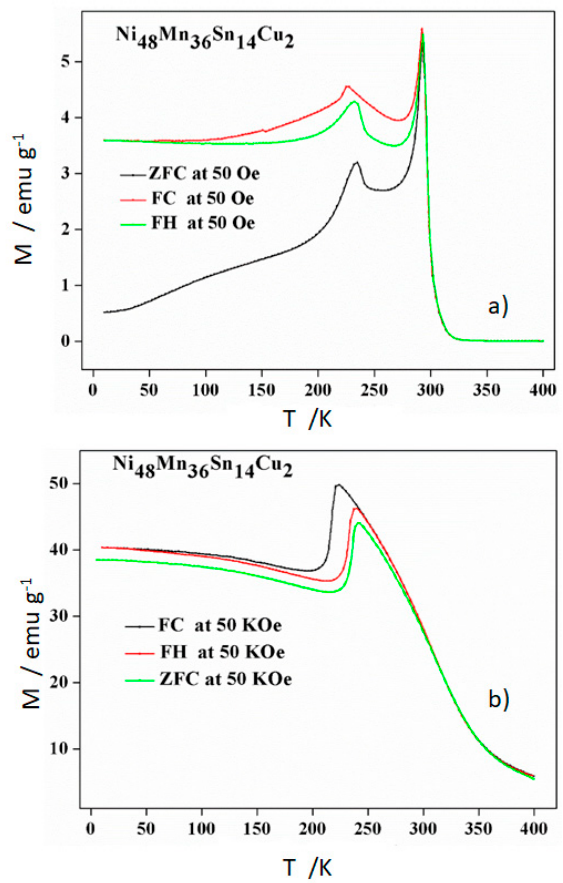
Figure 7. ZFC, FH, and FC thermomagnetic measurements of alloy Ni 48 Mn 36 Sn 14 Cu 2 . ( a ) 50 Oe and ( b ) 50 KOe.